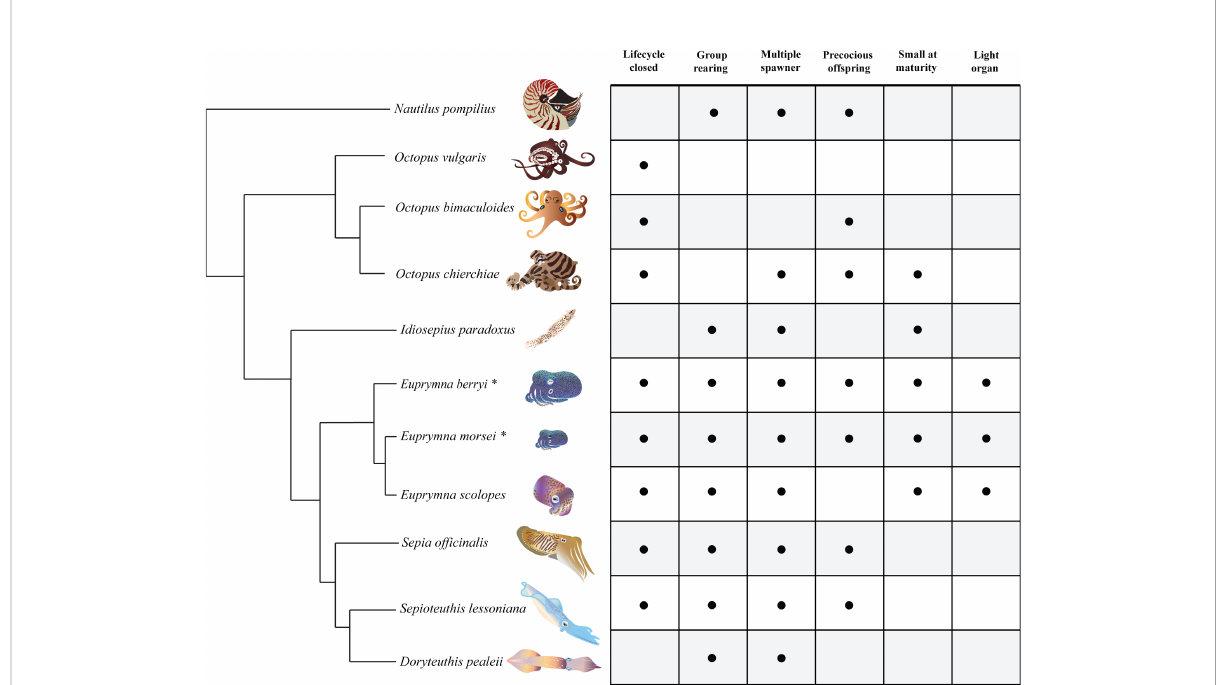
FIGURE 1 Advantageous Culture Traits of Several Cephalopod Models. Comparison of cephalopod species previously used in laboratory experiments. “ Lifecycle closed ” refers to a species being cultured across at least one generation. An animal is considered capable of group rearing if minimal aggression and cannibalism is observed, and the stress of group rearing prevents successful culturing efforts. “ Multiple spawner ” indicates normal multiple spawning events completed by one female. “ Precocious offspring ” refers to hatchling behaviors similar to adults (including predation). “ Small at maturity ” refers to an animal with a dorsal mantle length less than 6 cm. Some cephalopod species have evolved a light organ that is bioluminescent. The tree is based on results published by Anderson and Lindgren